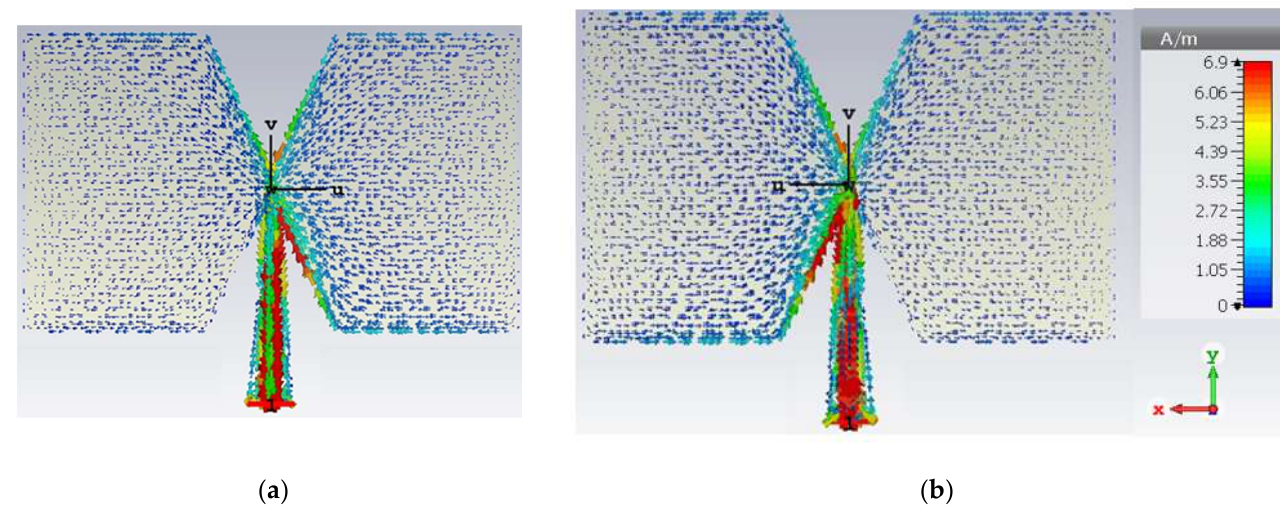
Figure 13. Surface currents distribution at 1 GHz: ( a ) front view, ( b ) back view.